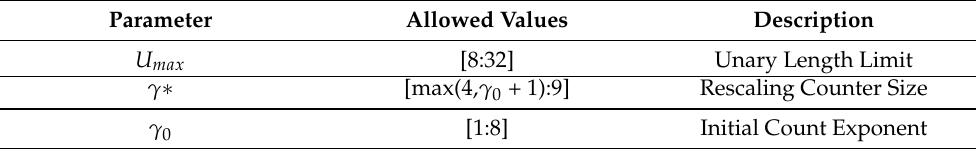
Table 1. Hybrid encoder